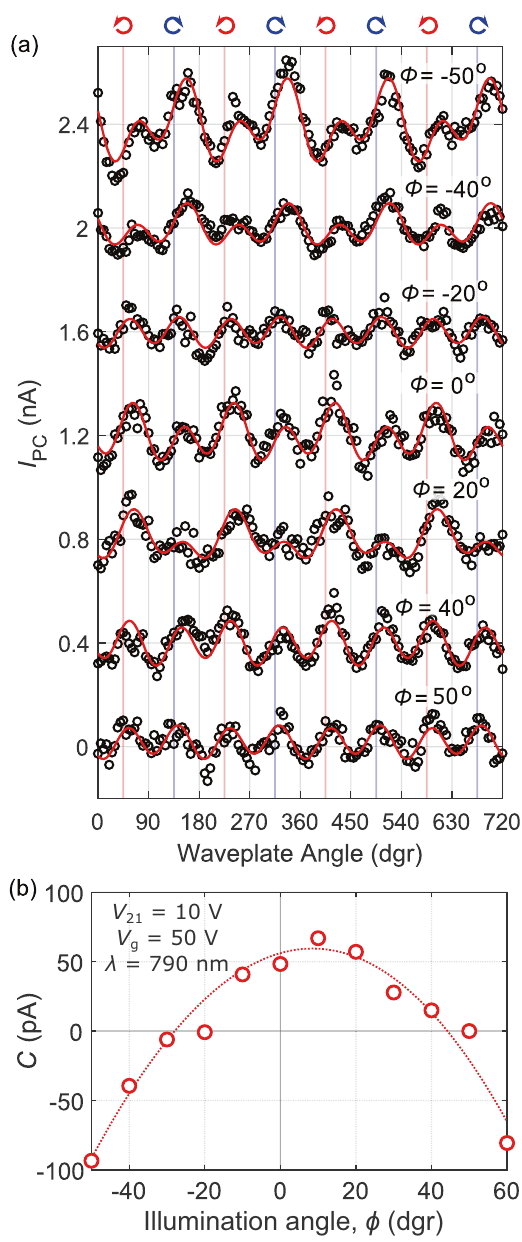
Fig. 4 Dependence of C on the illumination angle. a Photocurrent I PC for V 12 = 10 V and V g = 50 V as a function of the waveplate angle for different illumination angles. Dots indicate experimental data. Solid lines are fi ttings to Eq. 1. b Dependence of C on the illumination angle, extracted from the fi ttings shown in ( a ). The dotted line is a parabolic fi tting of the experimental data, shown as a guide to the